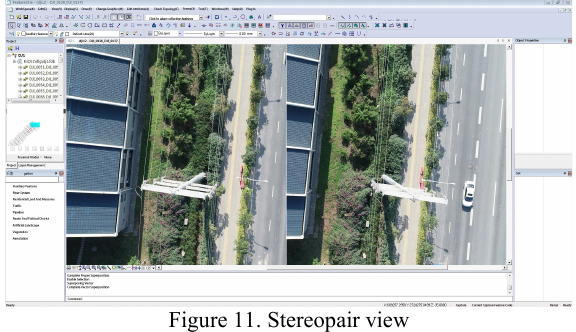
Figure 11. Stereopair view